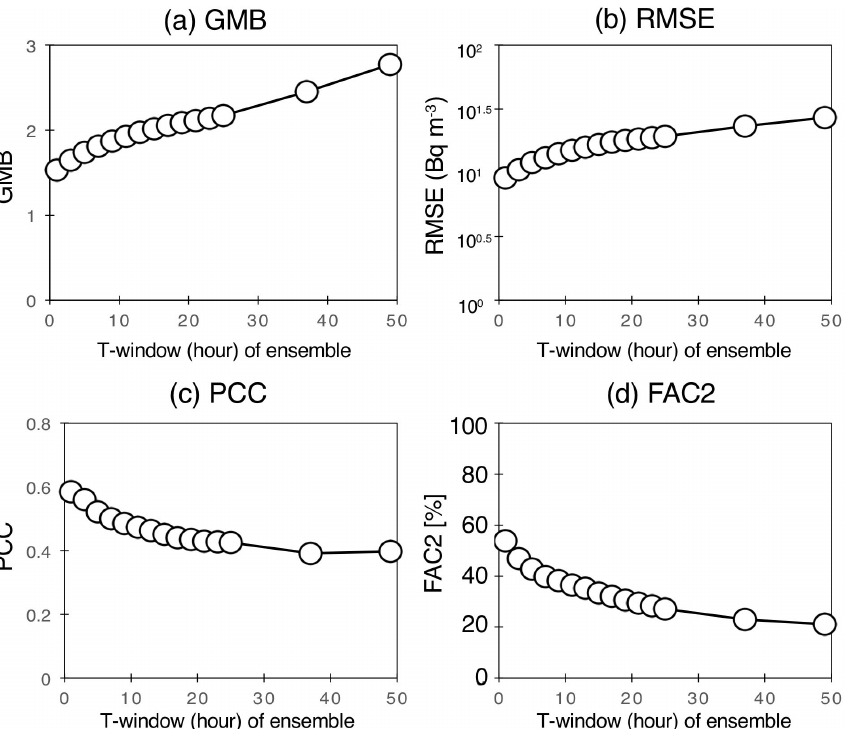
Figure 9. Statistical metrics (GMB, RMSE, PCC and FAC2) at the 101 available sites against various time windows ( x axis) ranging from 1 to